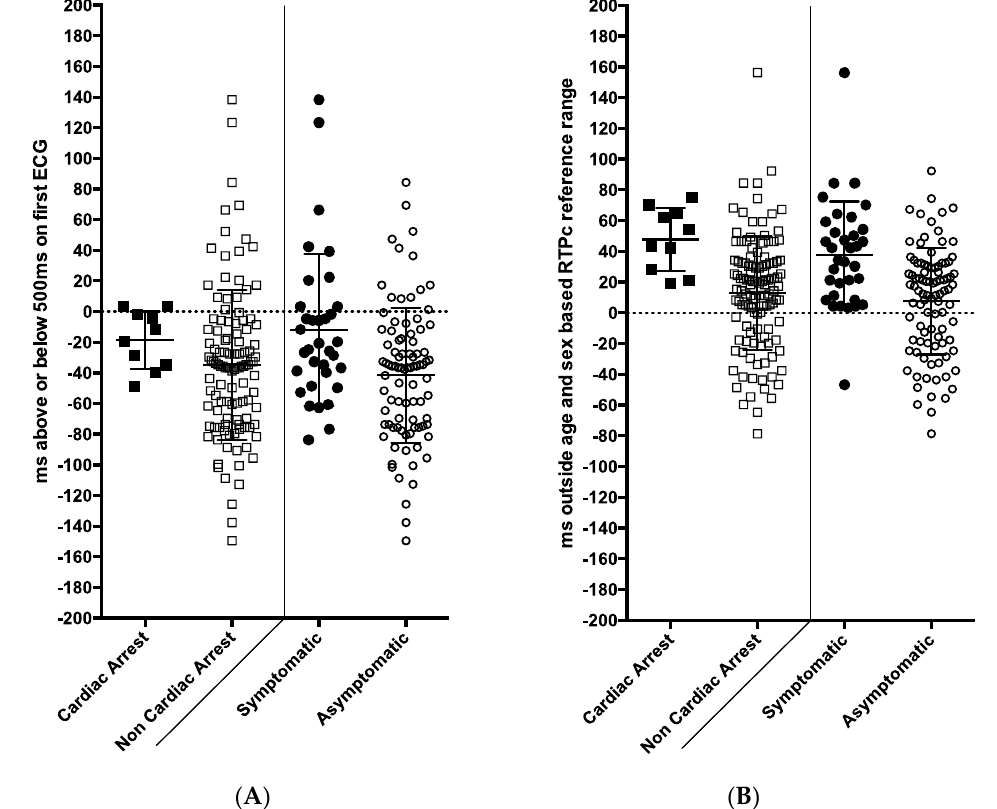
Figure 2. The association of ECG and Holter recording measurements with symptoms and cardiac arrest among families presenting for assessment with long QT syndrome (101 patients with long QT syndrome and 28 gene negative family members). ( A ) Panel shows QTc values from the initial 12 lead ECG expressed as milliseconds above the age/sex-based reference values. Only 2/10 patients who had cardiac arrest (left side) and 7/24 symptomatic patients (right side) had a QTc exceeding 500 ms on their first ECG. ( B ) This panel shows Holter-derived mean RTPc values (R wave to peak T wave corrected for heart rate) expressed as milliseconds above the age/sex-based reference range. Results from 10 cardiac arrest survivors are shown on the left versus the rest, and on the right the symptomatic versus asymptomatic subjects are shown. Only one symptomatic patient had a value in the normal range. ms = milliseconds. Black circle—LQTS with symptoms, black square—LQTS with cardiac arrest, white circle—all subjects (gene positive and negative) without symptoms, white square—all subjects (gene positive and negative) without cardiac arrest,